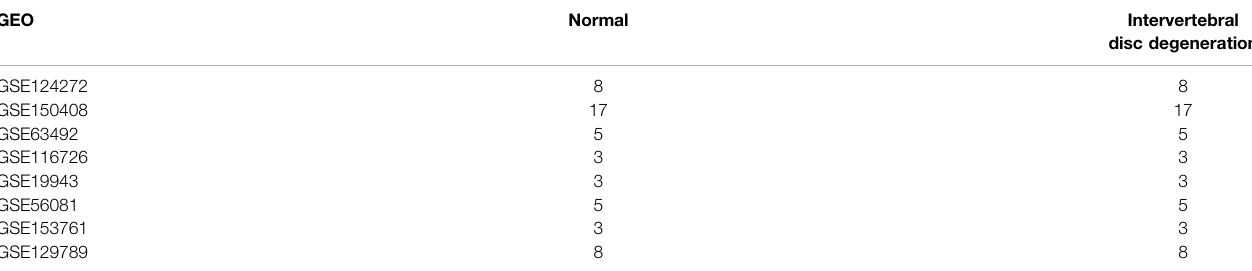
TABLE 1 | Information of data.